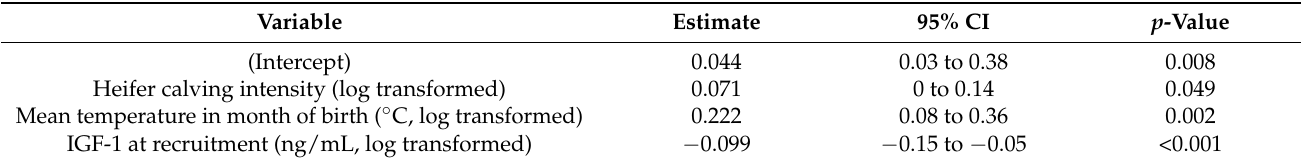
Table 5. Results of the linear mixed effects model for the composite umbilical infection score for dairy heifers ( n = 492 on 11 farms) in their first nine weeks of